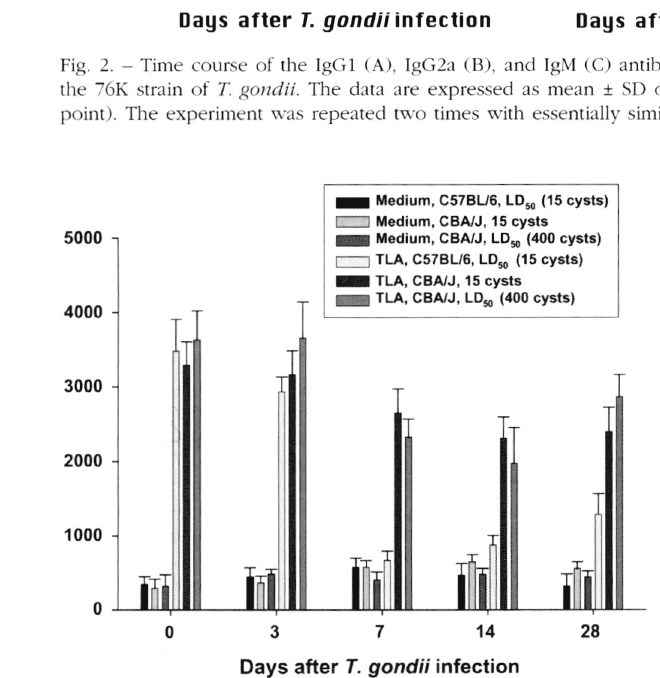
Fig. 3. - Proliferative responses of splenocytes from C57BL/6 and CBA/J mice orally infected with the 76K strain of T. gondii. Spleen cells were cultured in the presence of Toxoplasma lysate antigen for 72 h. The proliferation was assayed by [3H]-thymidine incorpo­ ration. Data are presented as the mean ± SD of one of two sepa­ rate experimets (n = 5 for each value at all time point). The experi­ ment was repeated two times with essentially similar results.